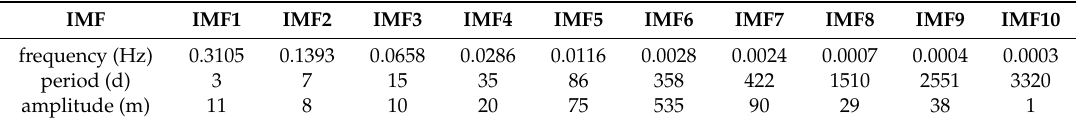
Figure 5. Altitude variation at 45° N from 2007 to 2015. Table 4. Characteristics of intrinsic mode functions (IMFs) obtained from Hilbert–Huang transform (HHT) of altitude variation at 45° N.